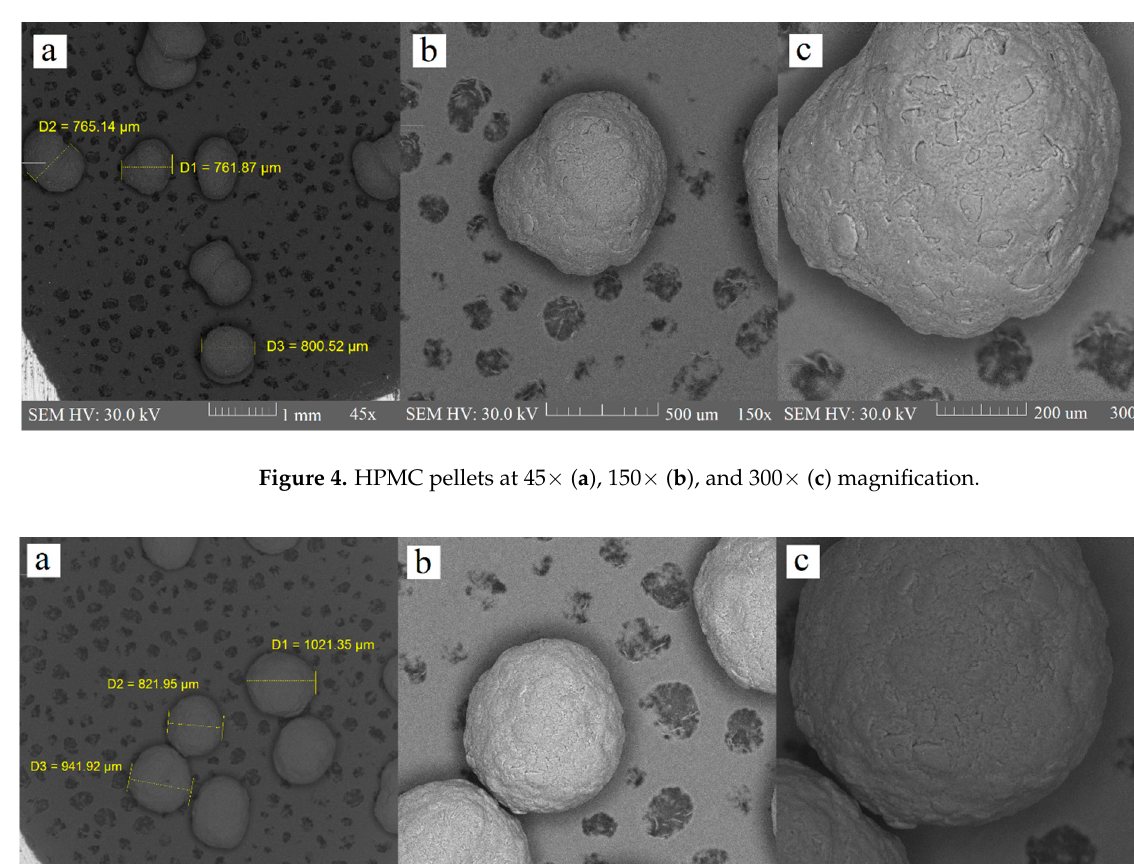
Figure 3. Alginate pellets at 45× ( a ), 150× ( b ), and 300× ( c ) magnification.